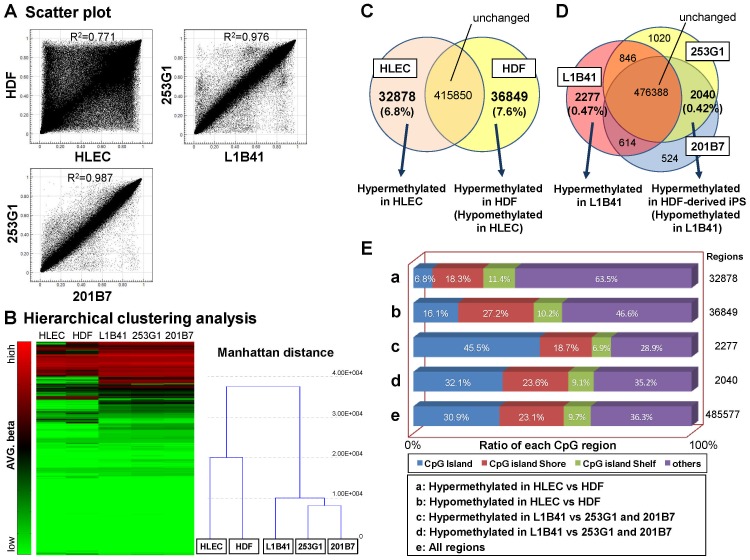
Genome wide DNA methylation analyses.(A) Scatter plots showed that a considerable difference in methylation status was observed between HLEC and HDF (A, R2 = 0.772). Between iPS cells (L1B41 vs. 253G1), the differences became smaller (R2 = 0.976), but were still larger than between 253G1 and 201B7 (R2 = 0.987). (B) The methylation status in HLEC, HDF and iPS cells was shown in the heatmap with green indicating unmethylated (low AVG-β) and red indicating fully methylated (high AVG-β). Hierarchical clustering analysis showed that L1B41 and 253G1 or 201B7 were differentially classified. (C) Comparing the methylation frequency between HLEC and HDF, 32878 hypermethylated regions (6.8%) and 36849 hypomethylated regions (7.6%) in HLEC were detected. (D) After reprogramming, 2277 hypermethylated regions (0.47%) and 2040 hypomethylated regions (0.42%) in L1B41 was detected by comparing between L1B41 and 253G1 or 201B7. (E) A large proportion of differentially methylated regions between HLEC and HDF were located in non-CpG islands (the ratio of CpG islands in hyper or hypomethylated regions in HLEC was 6.8% and 16.1%, respectively). Among iPS cells, a larger proportion of the differentially methylated regions were located in CpG islands (the ratio of CpG islands in hyper or hypomethylated regions in L1B41 was 45.5% and 32.1%, respectively).